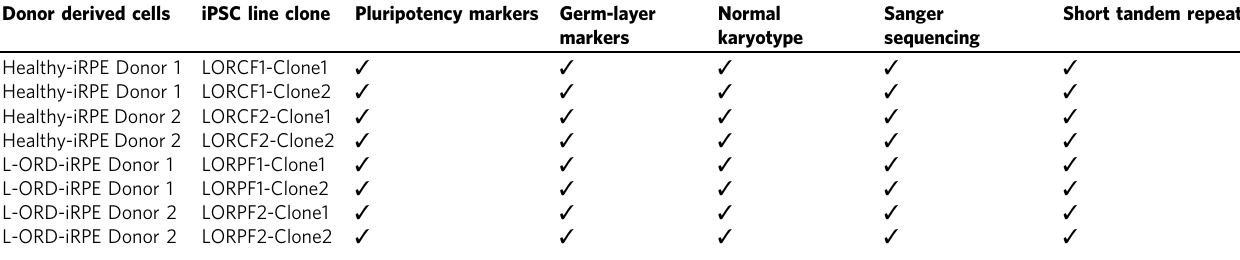
Table 1 Validation of pluripotency, presence of pathogenic C1QTNF5 variant, karyotyping was performed on iPSCs in the study. Identity (short tandem repeat) analysis was performed on iRPE and iPSCs to ensure no cross contamination. Donor derived